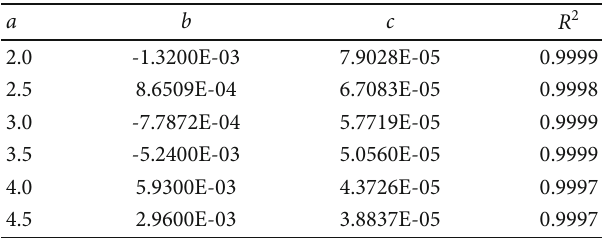
Figure 3: Relationships between P Table 3: Parameters of fi tting curves as shown in Figure